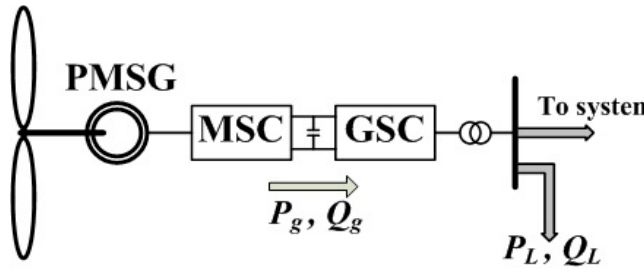
Figure 3. Connection diagram of a wind farm with a PMSG to the system.